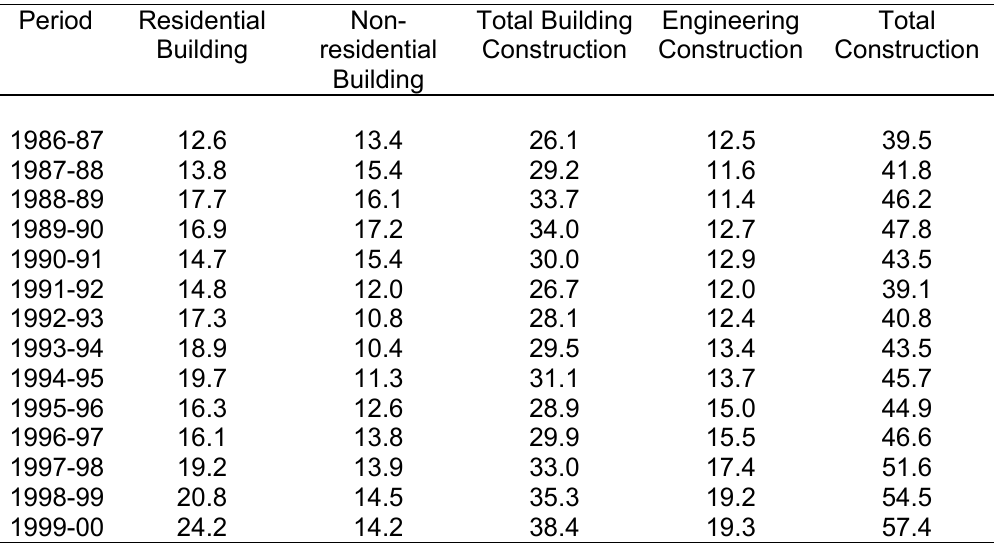
Table 1. Construction Activity, Chain Volume Measures: Reference Year 1998-99, Australia,